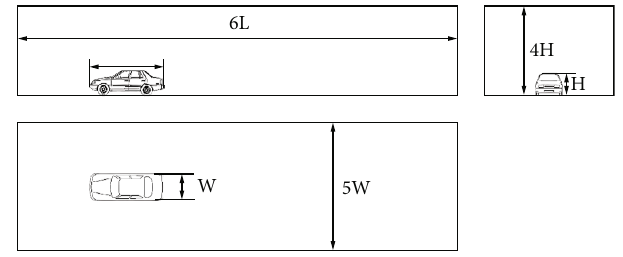
Figure 4: Settings for the calculation domain.